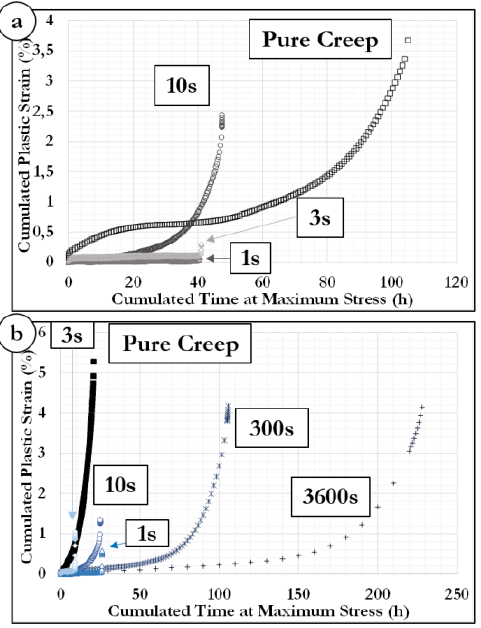
Figure 5. Plastic strain evolution during dwell-fatigue tests for different hold periods for the coarse grains microstructure: ( a ) σ max = 750 MPa, ( b ) σ max = 850 MPa at 700 °C.